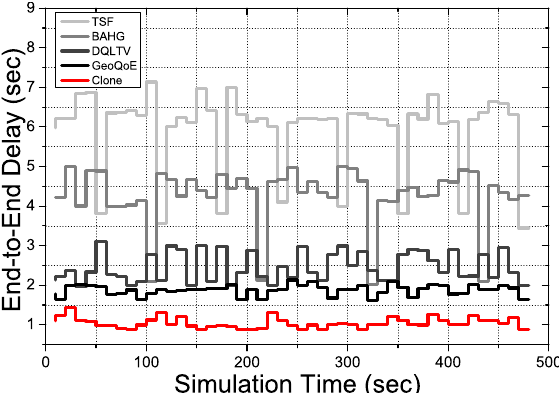
Figure 4. End-to-end delay results of the overall simulation